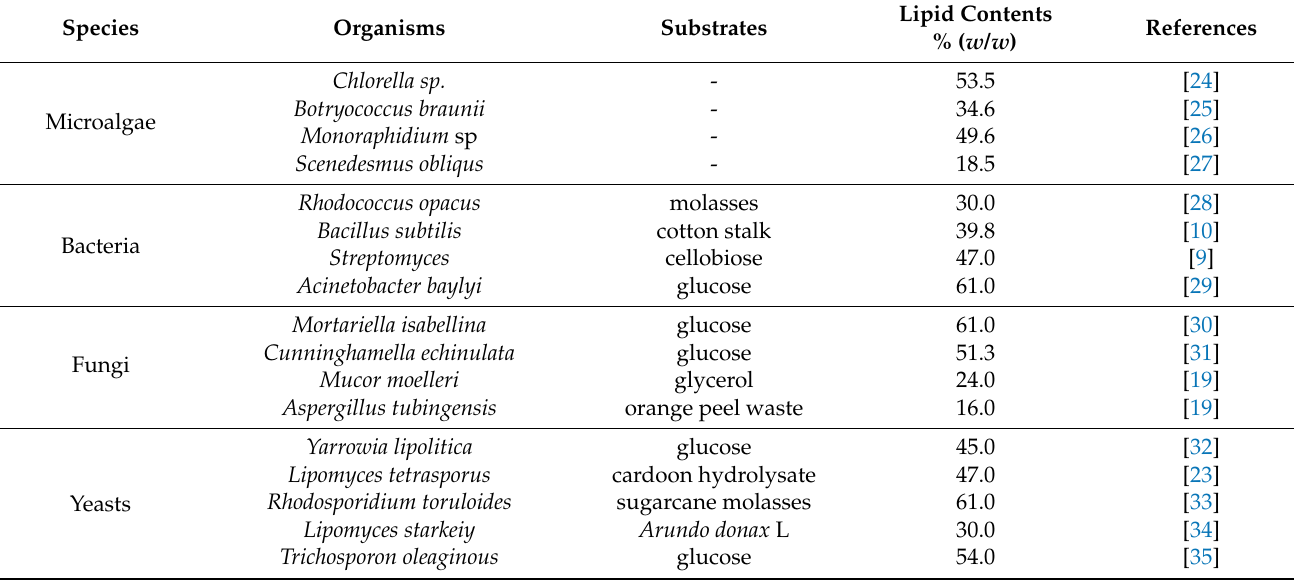
Table 1. List of main oleaginous species and lipid accumulation